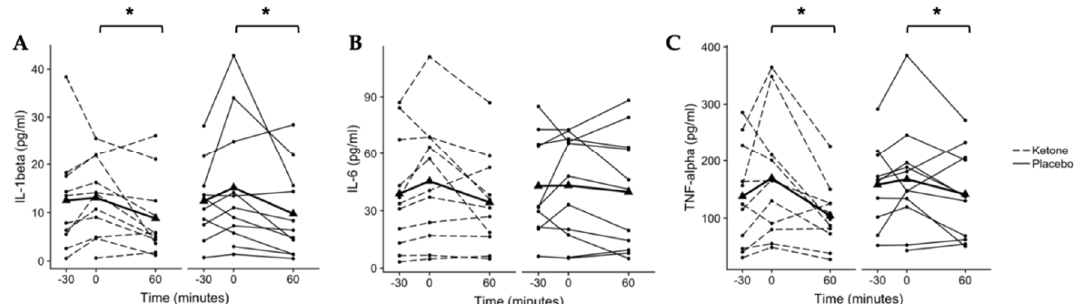
Figure 3. Secreted cytokines from LPS-stimulated whole-blood cultures. (A) A main effect of time was found for IL-1 β secretion ( p = 0.014) with a significant difference detected between 0 and 60 min (* p = 0.014, Bonferroni-corrected pairwise comparison). (B) No changes were observed for interleukin (IL)-6 ( p > 0.05). (C) A main effect of time was found for tumor necrosis factor (TNF)-alpha secretion ( p = 0.009) with a significant difference detected between 0 and 60 min (* p = 0.009 Bonferroni-corrected post hoc). Individual participant data are shown with the ketone condition represented by dashed lines and the placebo condition represented by solid lines. Means are shown by bold lines with triangles. n = 11.